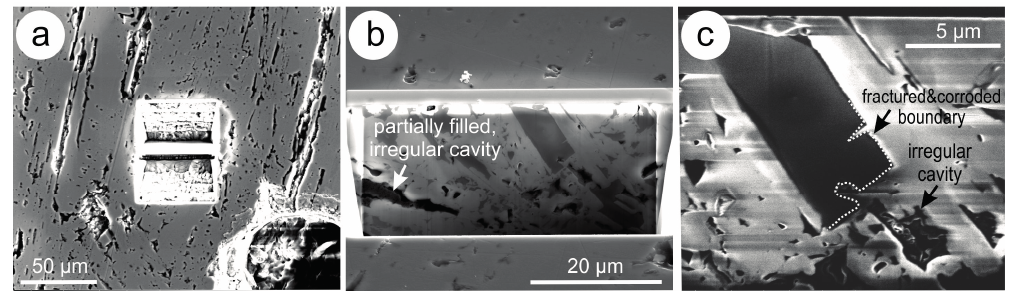
Figure 3. Secondary Electron (SE) images of Ge-Fe-poor area showing: ( a ) location of FIB cut roughly perpendicular to the elongation highlighted by sets of microfractures, trails of pores and secondary mineral inclusions; ( b ) extension of surface structures in depth exposed by FIB cross-sectioning. Note filled fractures and cavities (marked) at depth, as well as the presence of irregularly-shaped darker areas within a brighter matrix; ( c ) marginal cracks and relationships with larger pores lending the darker domains a relict character. The experimental methodology is the same as for Figure